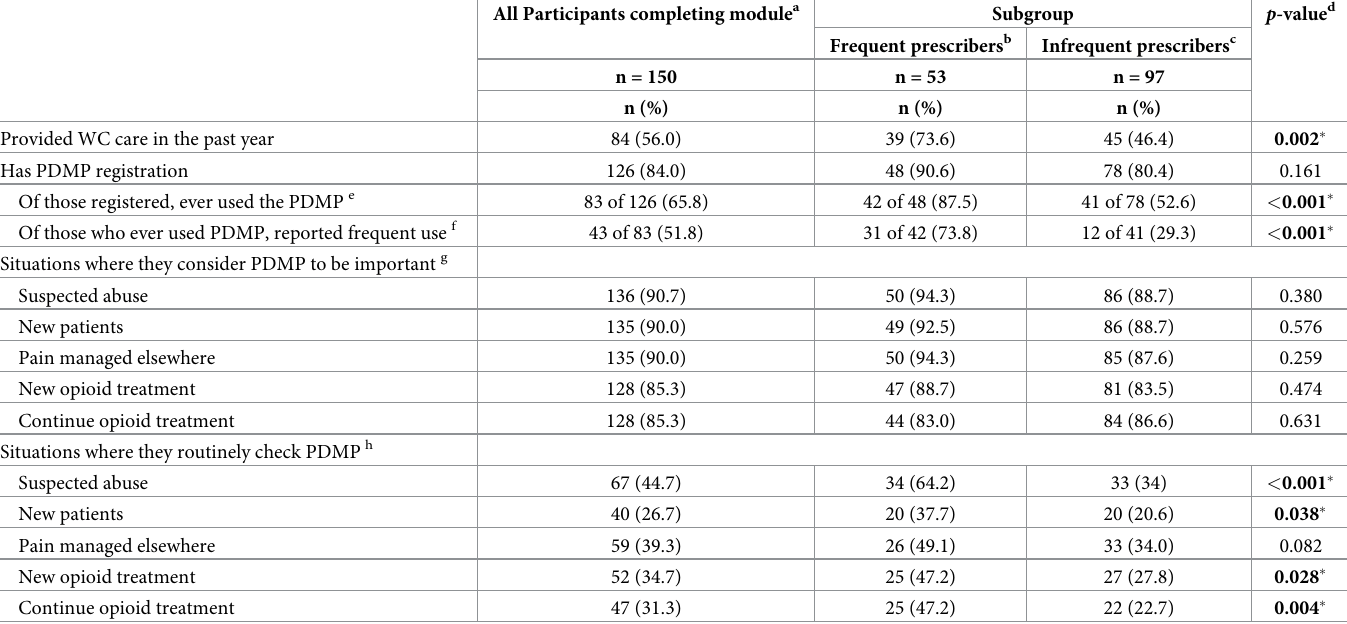
Table 1. Participant demographic characteristics, attitudes and self-reported PDMP behavior at